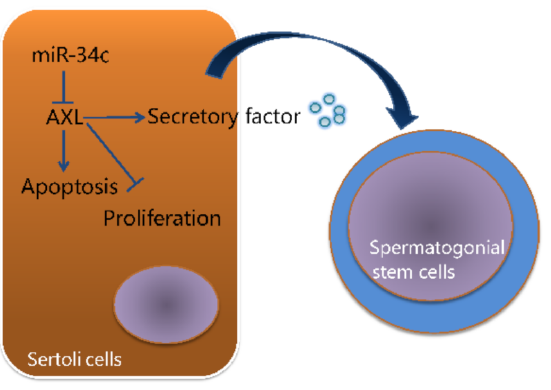
Figure 6. A schematic illustration of miR-34c targeting the AXL gene affects proliferation, apoptosis, and relative gene abundance of transcripts of reproduction-associated secreted factors in Sertoli cells.